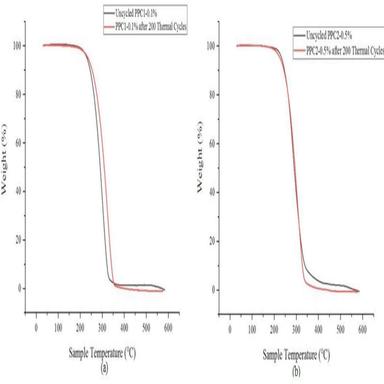
TGA Curve before and after 200 Thermal Cycles a) PPC1-0.1%& b) PPC2-0.5%.